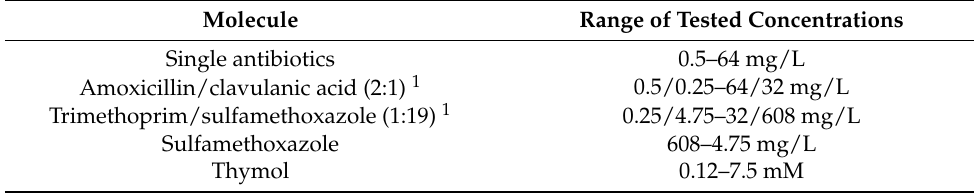
Table 10. Range of tested concentrations for all the compounds analyzed in the MIC